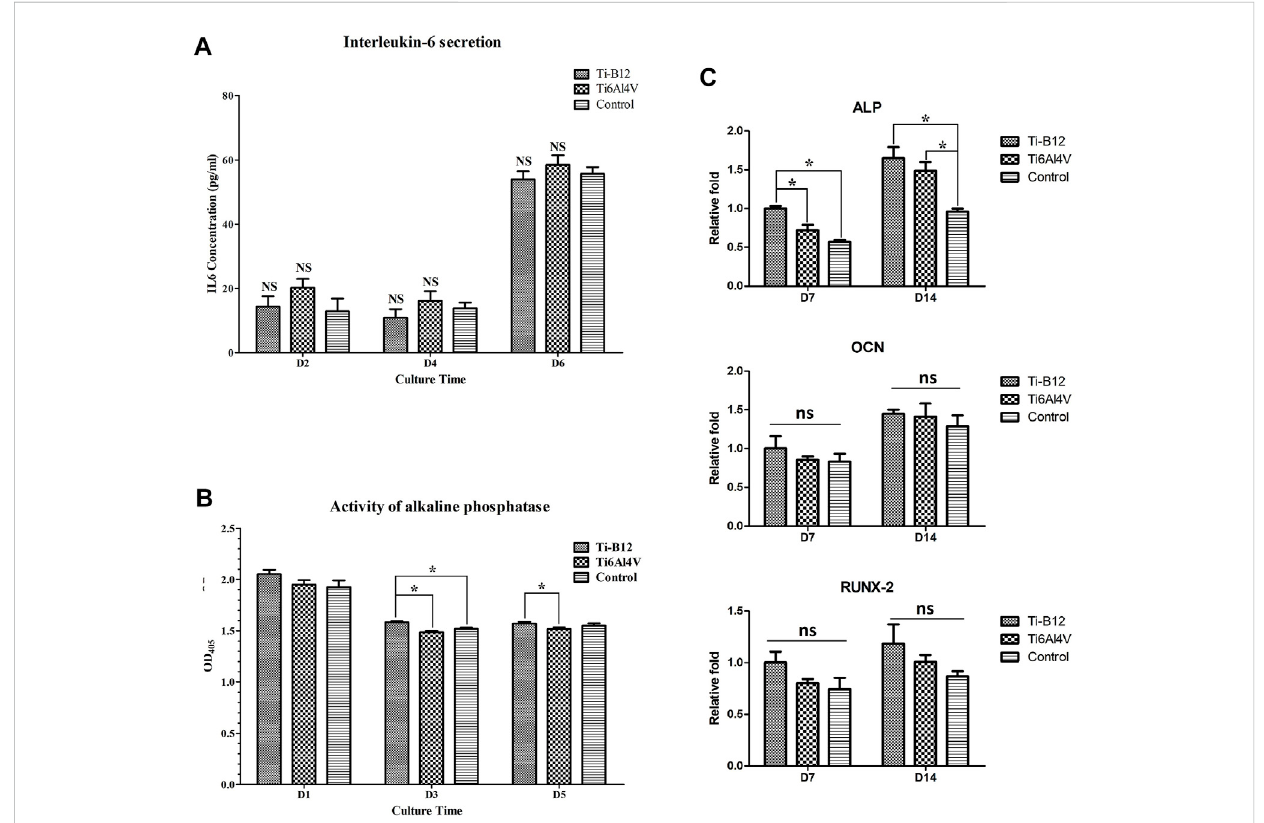
FIGURE 8 Detection of osteogenic properties in vitro . (A) detection of IL-6 secretion. (B) comparison of alkaline phosphatase activity. (C) expression of osteogenic-related